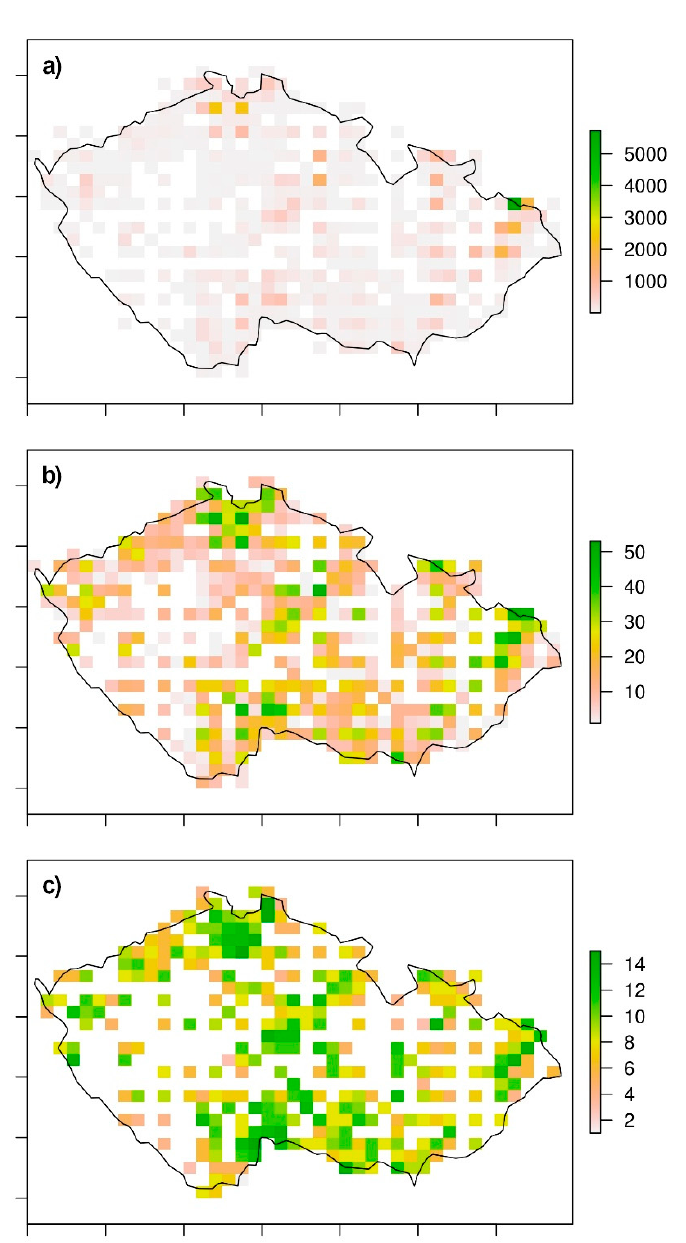
Figure 2. Records of odonates occurrences: ( a ) source distribution data, ( b ) source data of species richness, and ( c ) data of species richness after homogenisation.